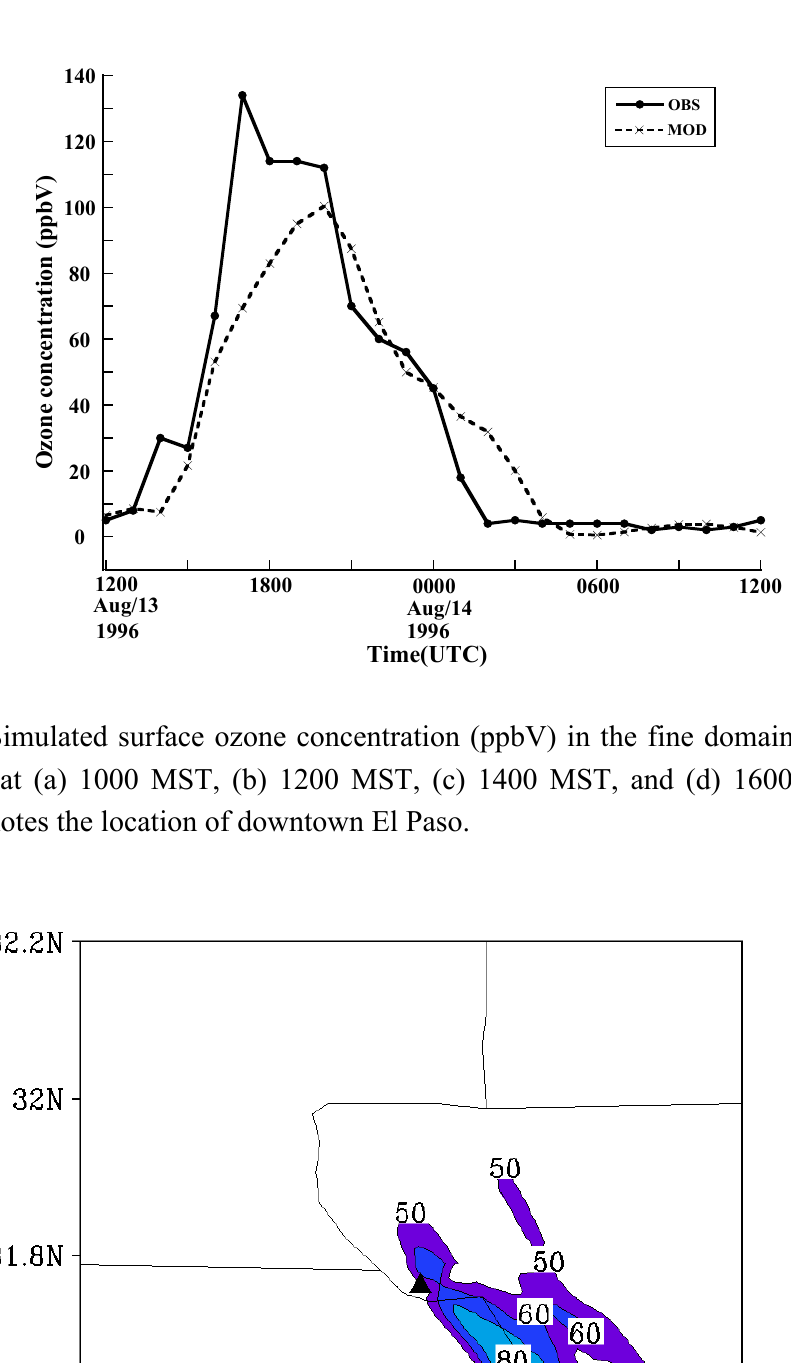
Figure 3. Surface ozone concentration comparison between model and observation at the location of downtown El Paso during the period from 1200Z 13 August to 1200Z 14 August 1996.